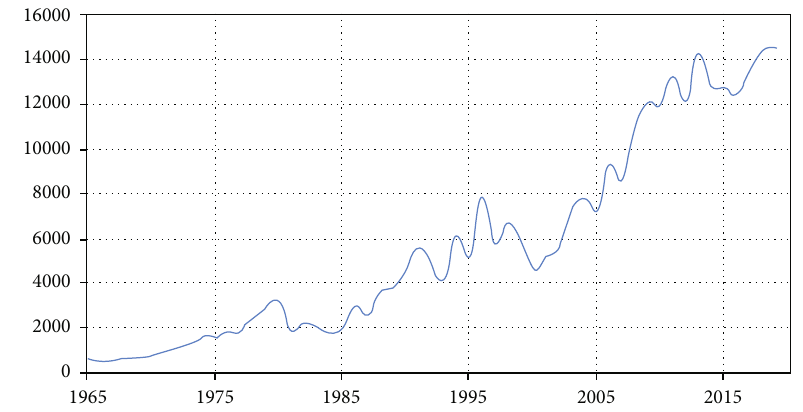
Figure 2: Morocco ’ s agricultural value added in M.USD.